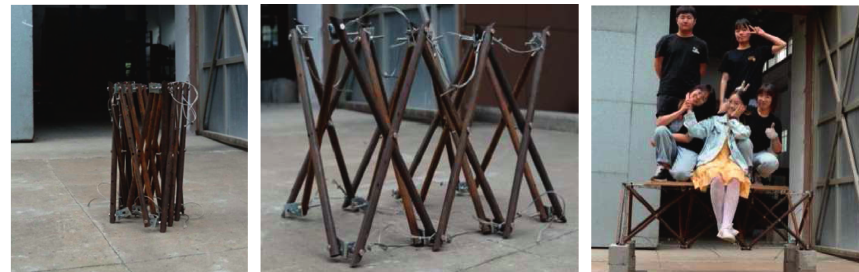
Figure 5: Physical model.